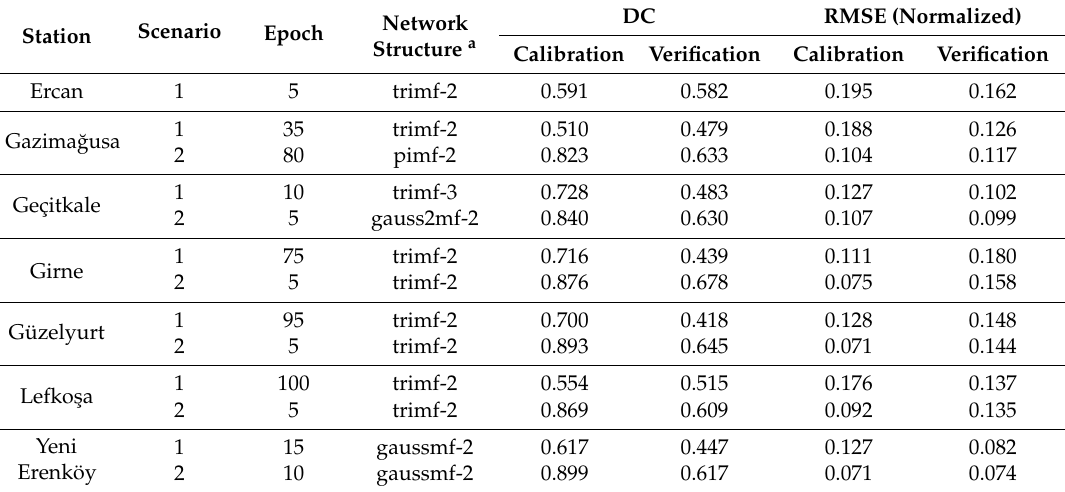
Table 5. Results of monthly precipitation predictions by ANFIS model both scenarios 1 and